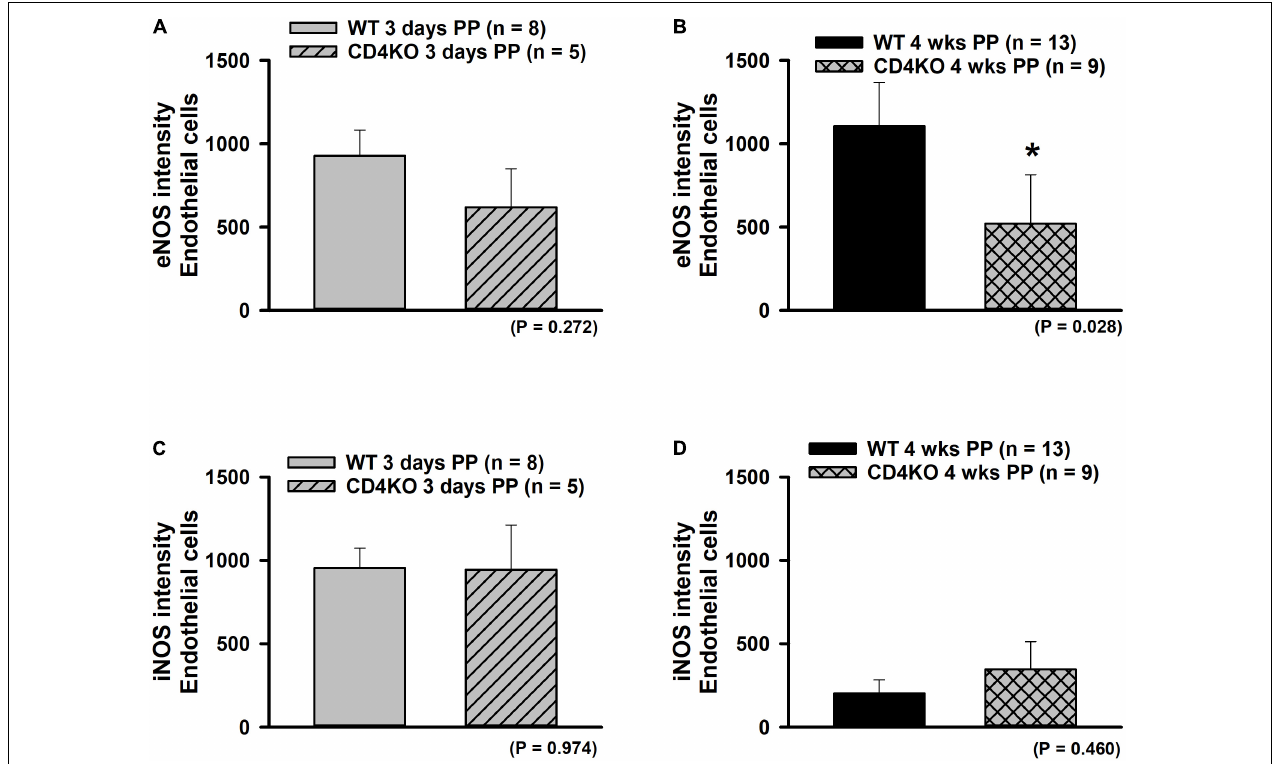
FIGURE 8 | The effect of pregnancy on eNOS and iNOS expression in endothelium of internal carotid arteries (ICAs) from C57BL/6 wild-type (WT) and CD4 T cell deficient (CD4KO) mice. (A,B) Bar graphs summarizing the expression of eNOS in endothelial cells of arteries from WT and CD4KO PP mice. eNOS expression tends to be lower in arteries from 3 days CD4KO PP vs. 3 days PP WT mice (A) . This trend reached a significance at 4 weeks PP (B) . (C,D) iNOS expression was not different in arteries from WT vs. CD4KO mice at any PP period (*significantly different at P < 0.05, unpaired t